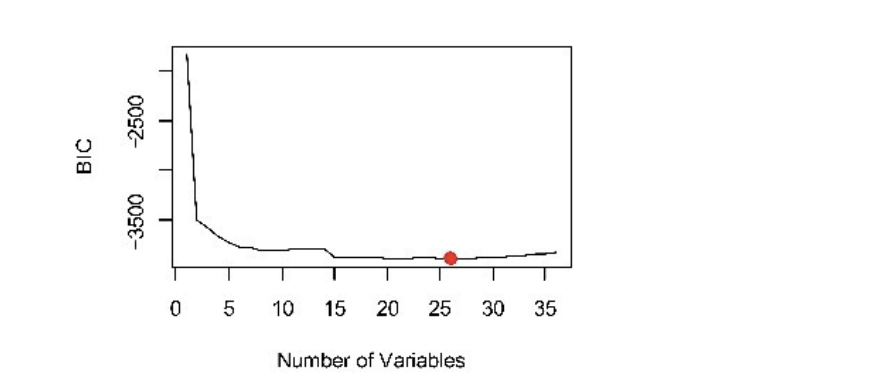
11 of 17 Figure 5. Random Forest. Scatter plot of the importance measure of the output variable. 3.3. Generalized Additive Model The number of variables predicted by the optimal model under the BIC criterion was 26 (Figure 6), including four stand structure variables, D (cid:3365) , N, VB, SDI, three topography variables, ALTITUDE, ASPECT, SLOPE, three cutting variables, CT, FCT, SCT, five diver ‐ sity variables, Richness, Chao1, Shannon, Simpson, Pielou, eleven climate variables, min ‐ PRES, minTEM, maxPRES, maxTEM, meanVaPRES, meanReHUM, meanminTEM, DaPREC_0.1, SunH, maxWindV, maxPREC. D (cid:3365) , SDI, Richness, Shannon, Simpson, ALTI ‐ TUDE, ASPECT, SLOPE, and maxPRES were used to construct the smooth spline func ‐